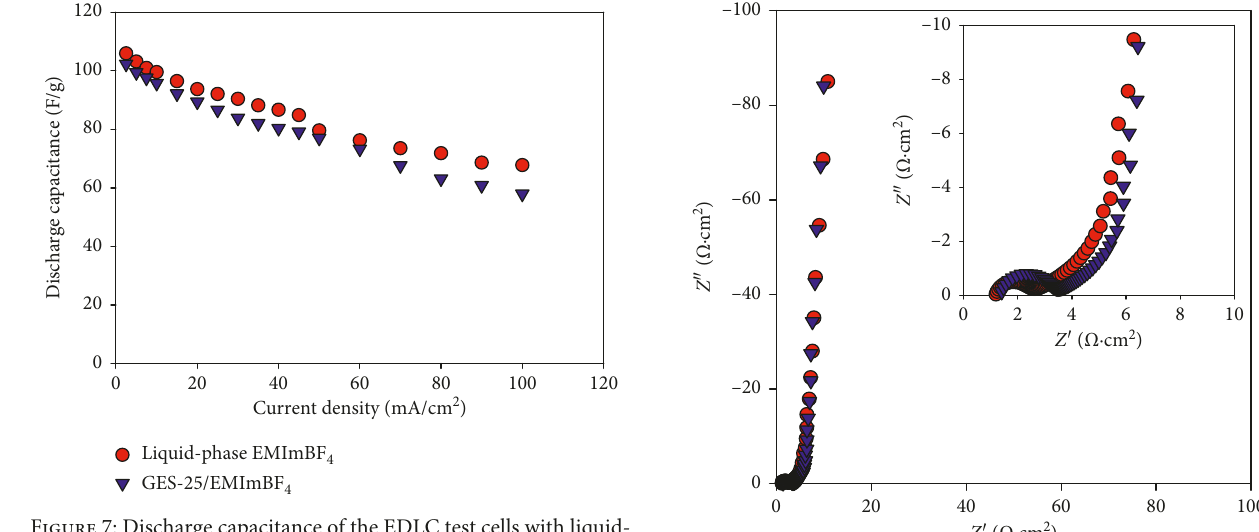
Figure 7: Discharge capacitance of the EDLC test cells with liquid- phase EMImBF 4 and with GES-25/EMImBF 4 as the electrolytes.